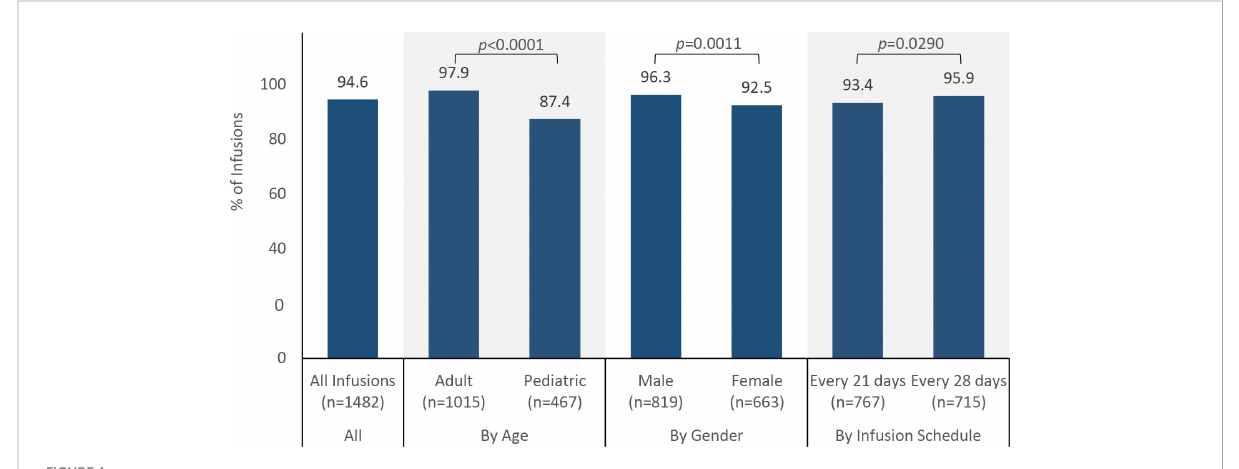
FIGURE 1 Percentage of infusions in which the maximum infusion rate was achieved, by subgroup.